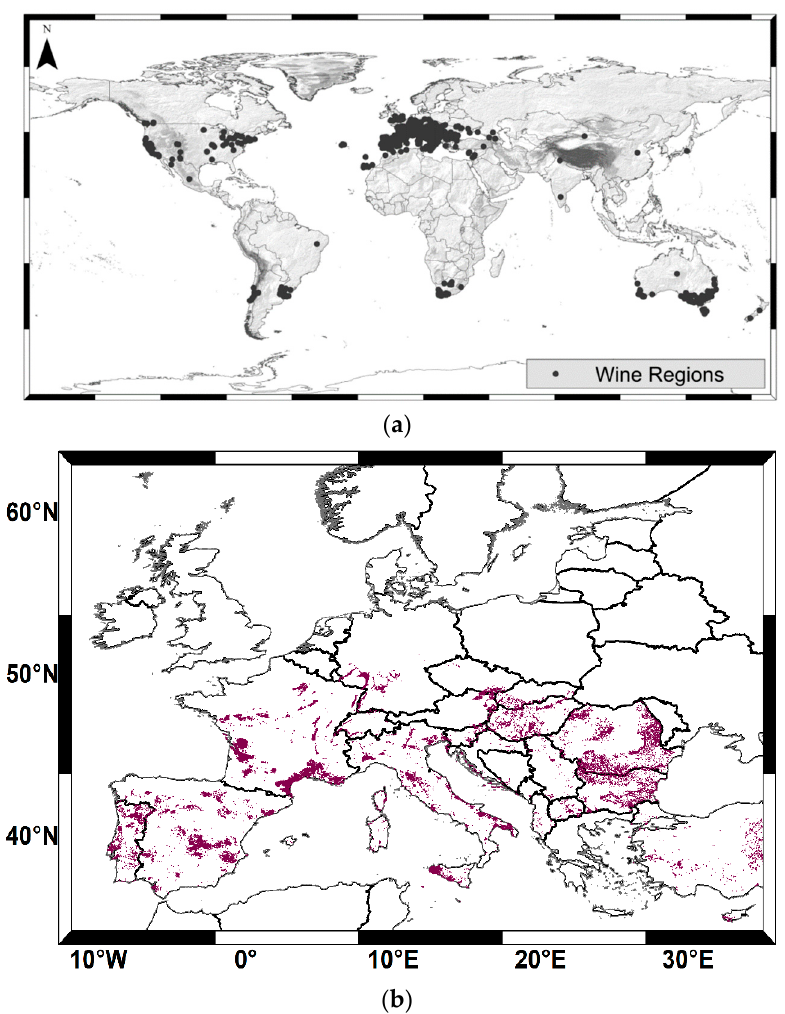
Figure 1. ( a ) World distribution of the viticultural regions (black circles) [4]. ( b ) Political map of Europe with the vineyard land cover (shading). Source: Copernicus CORINE Land Cover (CLC) 2018 (https://land.copernicus.eu/).